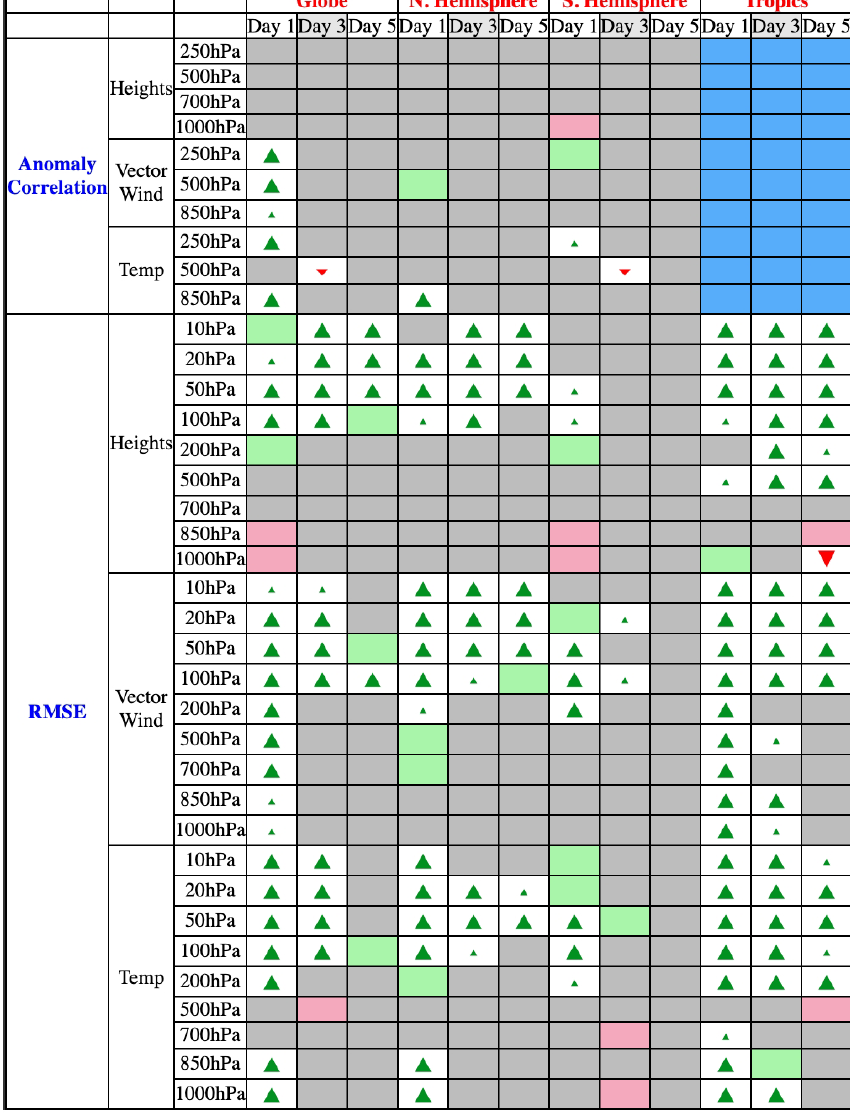
Figure 7. Scorecard of anomaly correlation and RMSE of comparison between AER_cyc and CTL_cyc. Green colors mean AER_cyc is better than CTL_cyc at 95% (filled box), 99% ( ), and 99.9% ( ) significance level. Red colors mean AER_cyc is worse than CTL_cyc at 95% (filled box), 99% ( ), and 99.9% ( ) significance level. Grey boxes mean no statistically significant difference between AER_cyc and CTL_cyc. Blue boxes are not statistically relevant. The statistics are calculated between 20 to 80 ◦ of latitude for both hemispheres. The data between 20 ◦ S and 20 ◦ N are used for the tropical